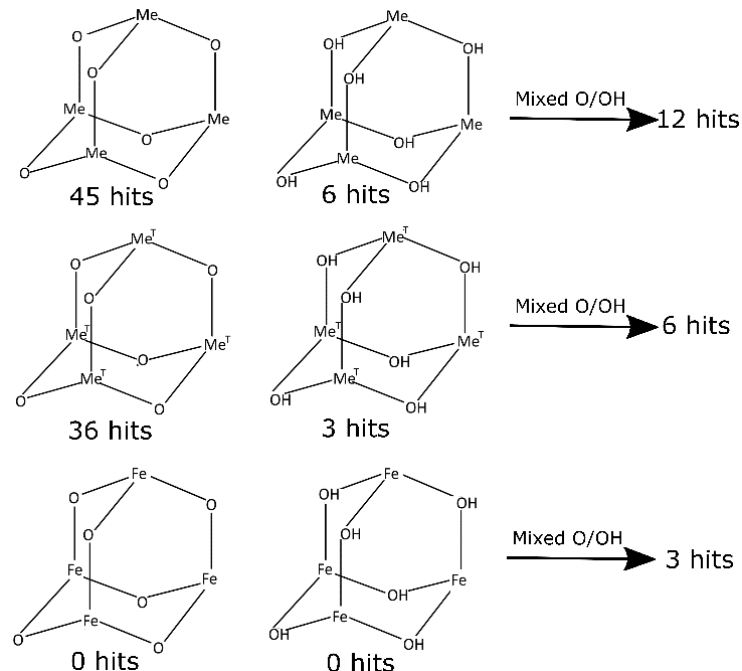
Scheme 1. Structural models used for CSD searches. Notation: Me—any metal, O—oxo and OH- hydroxo bridging atoms, Me T -any transition metal.